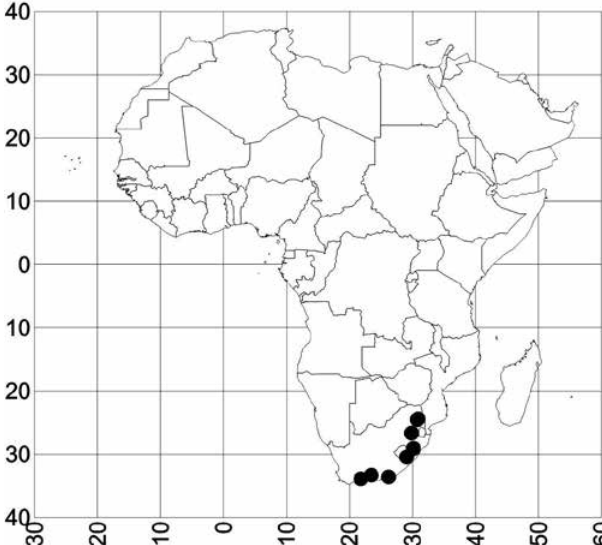
Map 3 . The distribution of B. berthoudi .